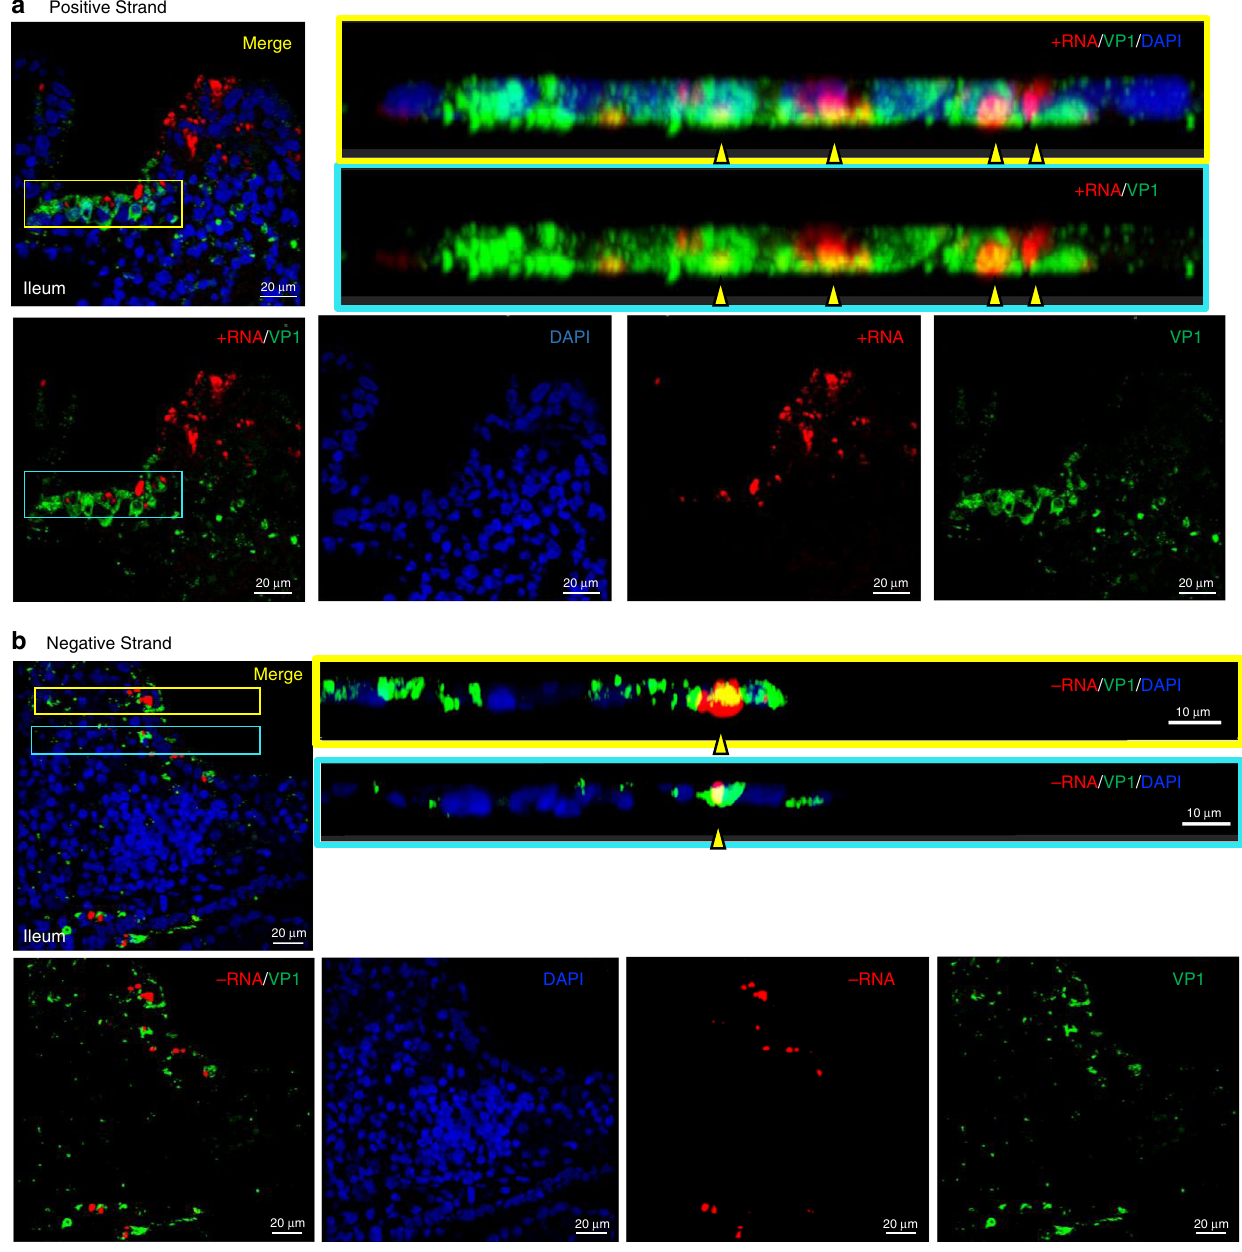
Fig. 3 Association of capsid VP1 expression with positive or negative-sense viral RNA. a Confocal microscopy imaging of VP1 (green, visualized with TV19) and positive-sense RNA (red, hybridized with positive RNAscope probe) in the GT-1 ileal biopsy. Merged and separate staining patterns for each marker are shown. Side views of the merged images show overlap of positive-sense RNA and VP1 expression (indicated by yellow arrows) in the presence or absence of DAPI staining. b Confocal microscopy imaging of VP1 (green, visualized with TV19) and negative-sense RNA (red, hybridized with negative RNAscope probe) in the GT-1 ileal biopsy. Merged and separate staining patterns for each marker are shown. The overlap between VP1 and negative-sense RNA is shown in two cross sections (yellow arrows) from proximal regions in the tissue (inset box outline colors correspond to highlighted regions in merged ( b) association with myeloid immune cell markers (Figs. 6a and overlapping signals, but further analysis illustrated that the 5b). There was no consistent association of the viral VP1 RNA signal was on the periphery of the T cell membrane antigen (brown) with CD3-positive T cells (red) within the (Supplementary Movie 5). Likewise, the CD20-positive B cells lamina propria or in subepithelial locations (Fig. 6d). Con- found throughout the lamina propria and in lymphoid tissue sistent with this, there was little evidence of association between did not co-localize or associate with virus antigen or RNA. VP1 and CD4-positive T helper cells (Fig. 6e) or VP1 and Confocal imaging of the GT-1 biopsy with both T and B cells CD103-positive intraepithelial lymphocytes (IELs) (Fig. 6f). markers and the negative-sense RNAscope probe failed to Confocal microscopy of a region of the GT-1 biopsy probed for detect co-localization within these immune cells in this study CD4 and the norovirus positive-sense RNA showed possible (Fig. 6g and Supplementary Movie 6).